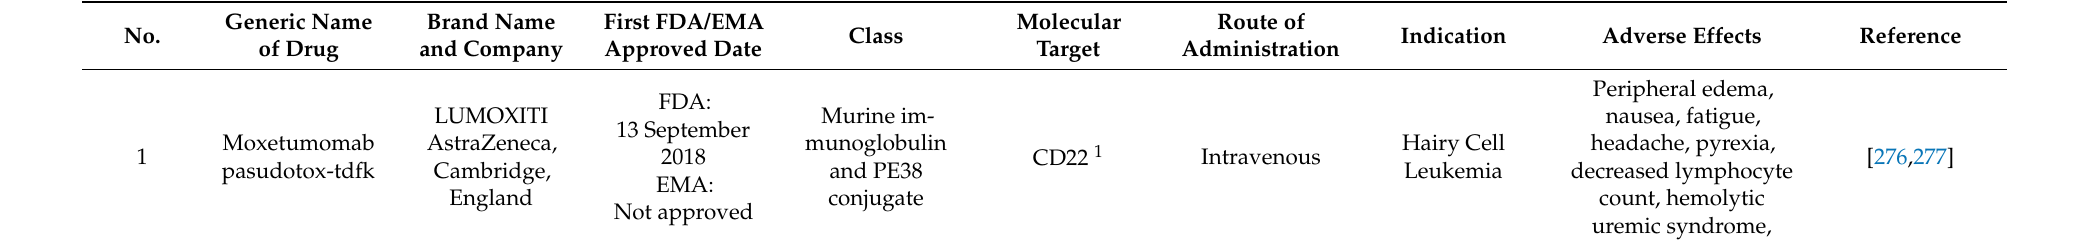
Table 14. Features of the immunotoxin drug approved by the Food and Drug Administration (FDA) from 2011 to